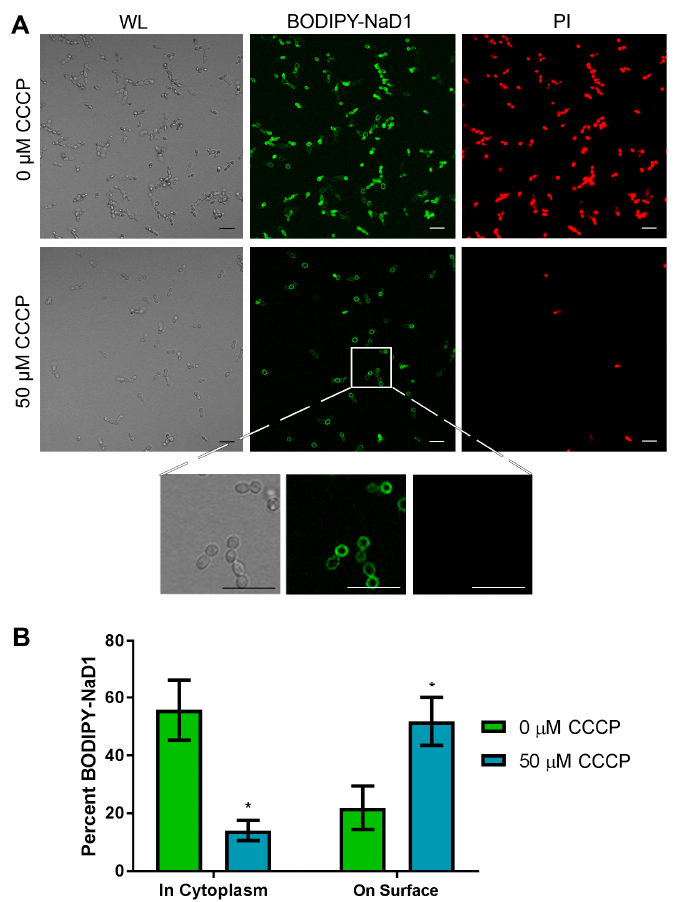
Figure 3. NaD1 uptake is reduced after treatment with CCCP. ( A ) Confocal microscopy was used to monitor uptake of BODIPY-NaD1 into C. albicans DAY185 after pre-treatment with CCCP. CCCP pre-treated cells (50 µM CCCP) and no-inhibitor control (0 µM CCCP) cells were treated with 10 µM BODIPY-NaD1 for 10 min. BODIPY-NaD1 and PI and white light images are shown. Scale bars = 40 µm. A subset of cells is also shown with increased magnification. Scale bars = 40 µm. Images are a representative example of three independent experiments, which gave equivalent results. ( B ) Cell counts were performed for four independent experiments and the percentage of BODIPY-labelled NaD1 bound to the membrane or in the cytoplasm was plotted relative to total cell counts. Error bars are standard error of the mean ( n = 4). Values marked by an asterisk are significant (using an independent t -test) compared to the 0 µM CCCP control ( p -value < 0.05).